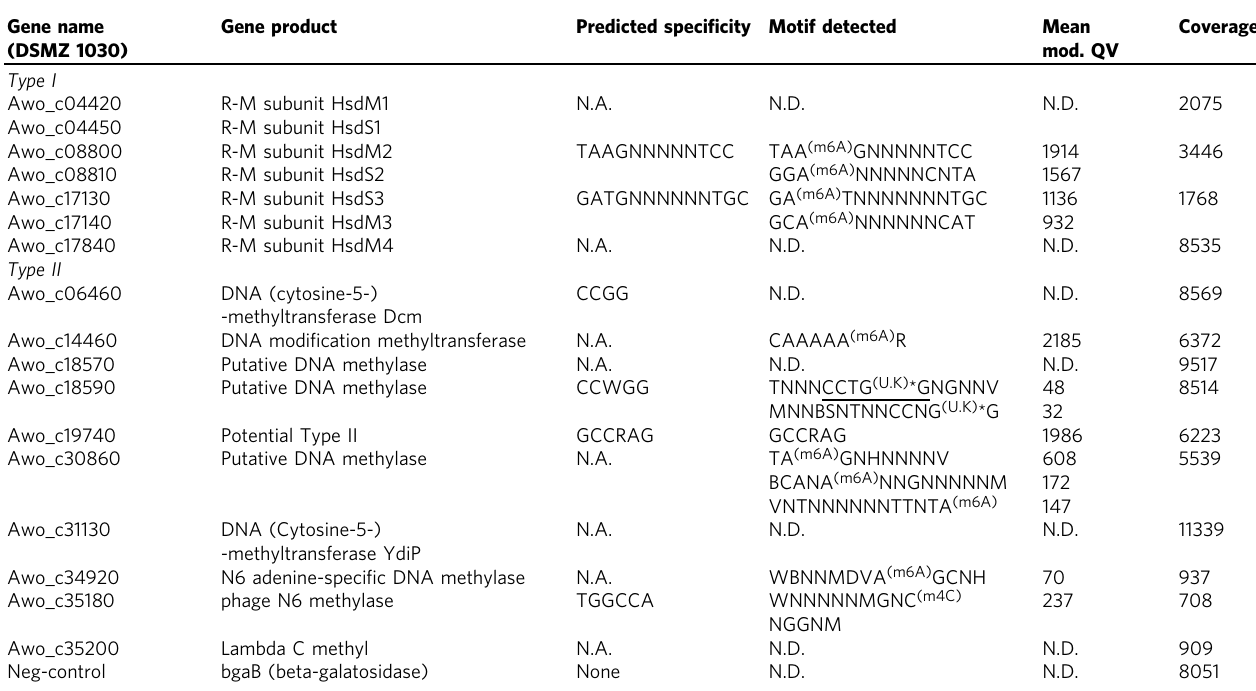
Table 3 Summary of the methyltransferases from A. woodii